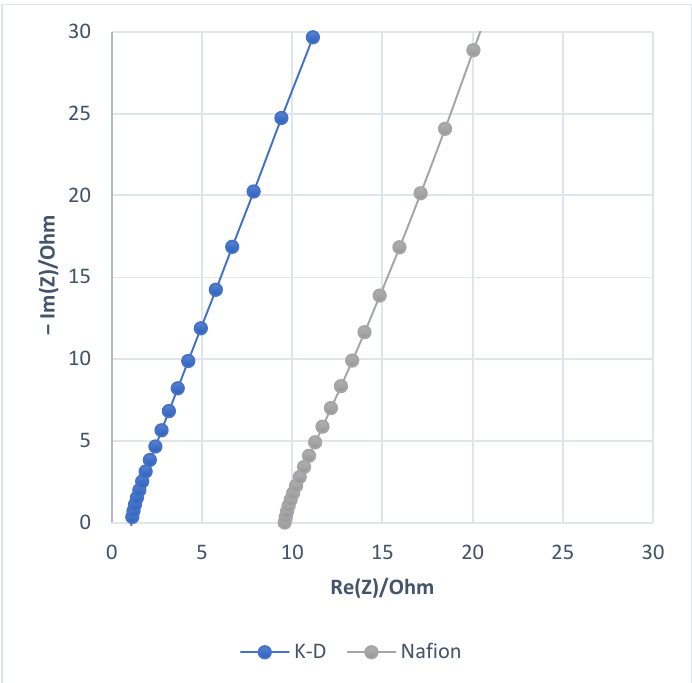
Figure 2. Typical complex impedance diagrams of a SPEEK membrane cast in DMSO (K-D) and a Nafion TM membrane after immersion in buffer.